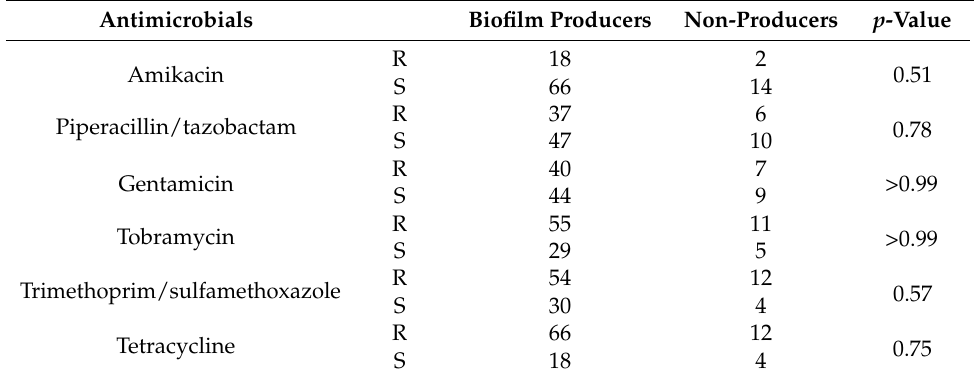
Table 4. Relationship between biofilm production and AMR.